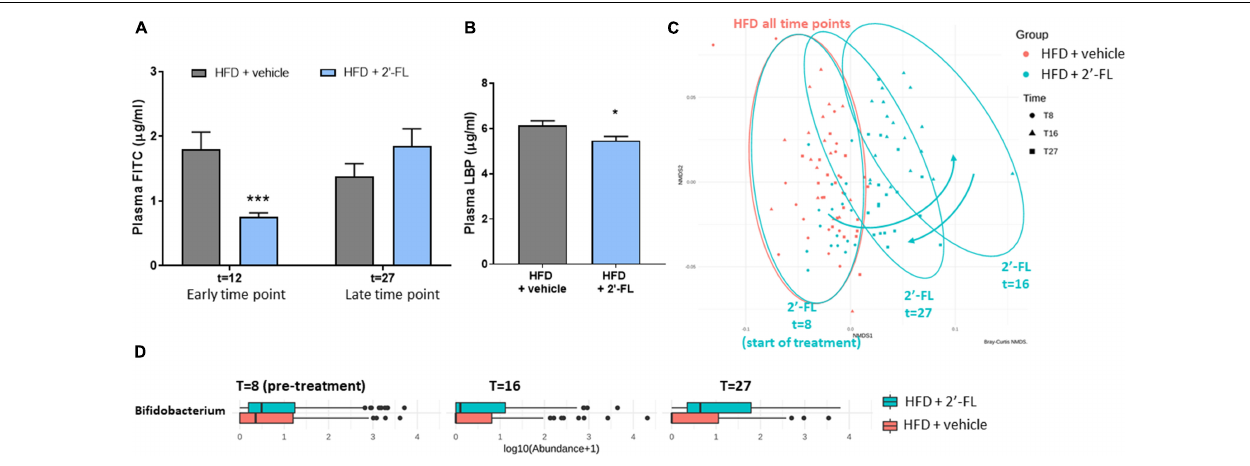
FIGURE 4 | Human milk oligosaccharide 2 (cid:48) -FL improves gut permeability during early NAFLD development. (A) Gut permeability measured by FITC-labeled dextran at an early (at t = 12 w) and late (at t = 27 w) time point of the disease process equaling 4 and 19 weeks of 2 (cid:48) -FL supplementation, respectively. (B) Plasma LPS-binding protein (LBP) measured in week 28 of the study. Data is from n = 18 mice per treatment group presented as mean ± SEM, * p < 0.05, *** p < 0.001 compared to HFD + vehicle. (C) Fecal microbiota composition was analyzed by 16S sequencing and composition changes over time were visualized by non-metric multidimensional scaling (NMDS) using the Bray-Curtis index. Every dot represents the microbiota composition of one mouse. A greater distance between dots indicates more dissimilarity. Blue arrows indicate 2 (cid:48) -FL induced microbiota composition shifts. (D) Fecal Bifidobacterium abundance over time.